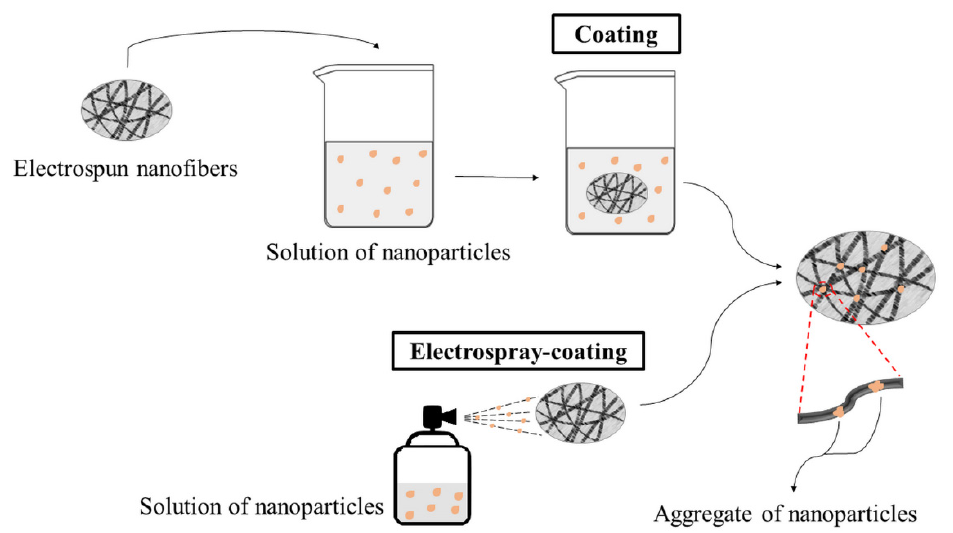
Figure 8. Coating and electrospray-coating modifications techniques schema.